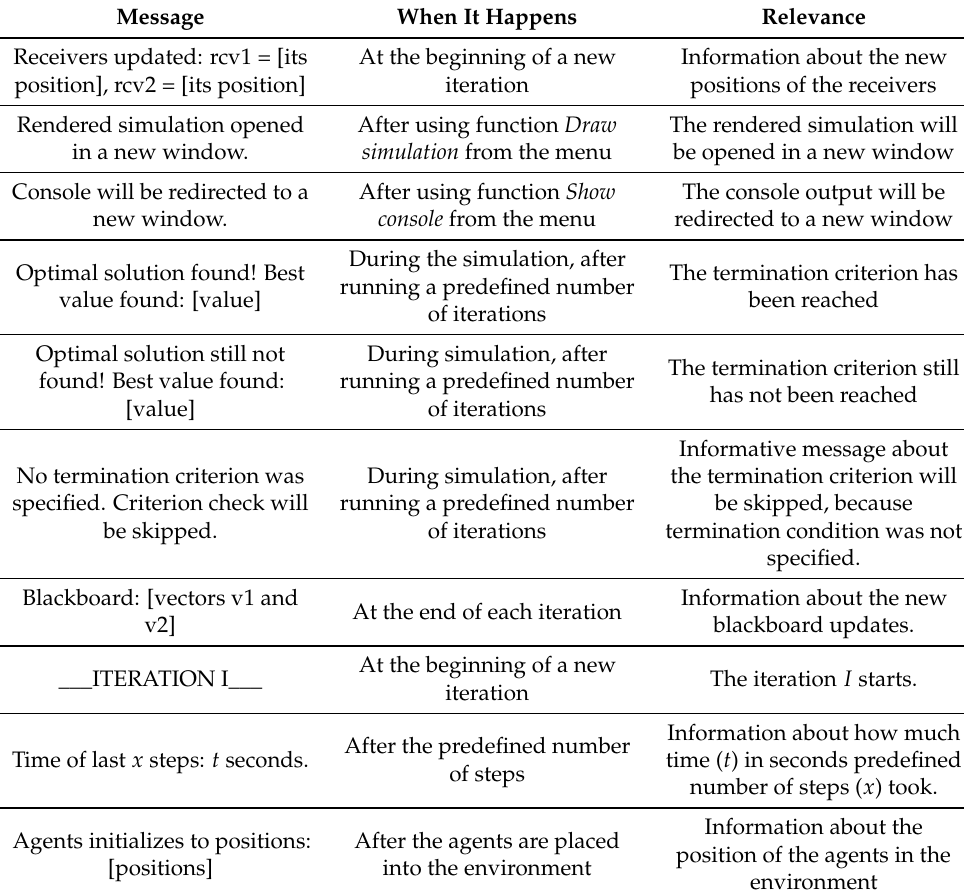
Table A2. Informative